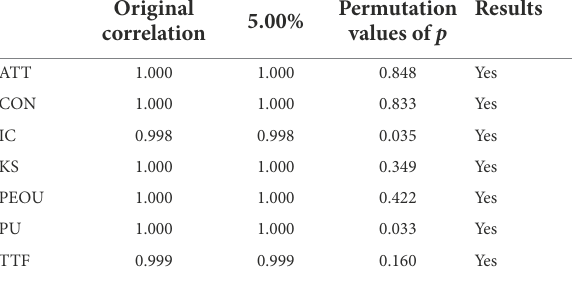
TABLE 10 MICOM step 2 results